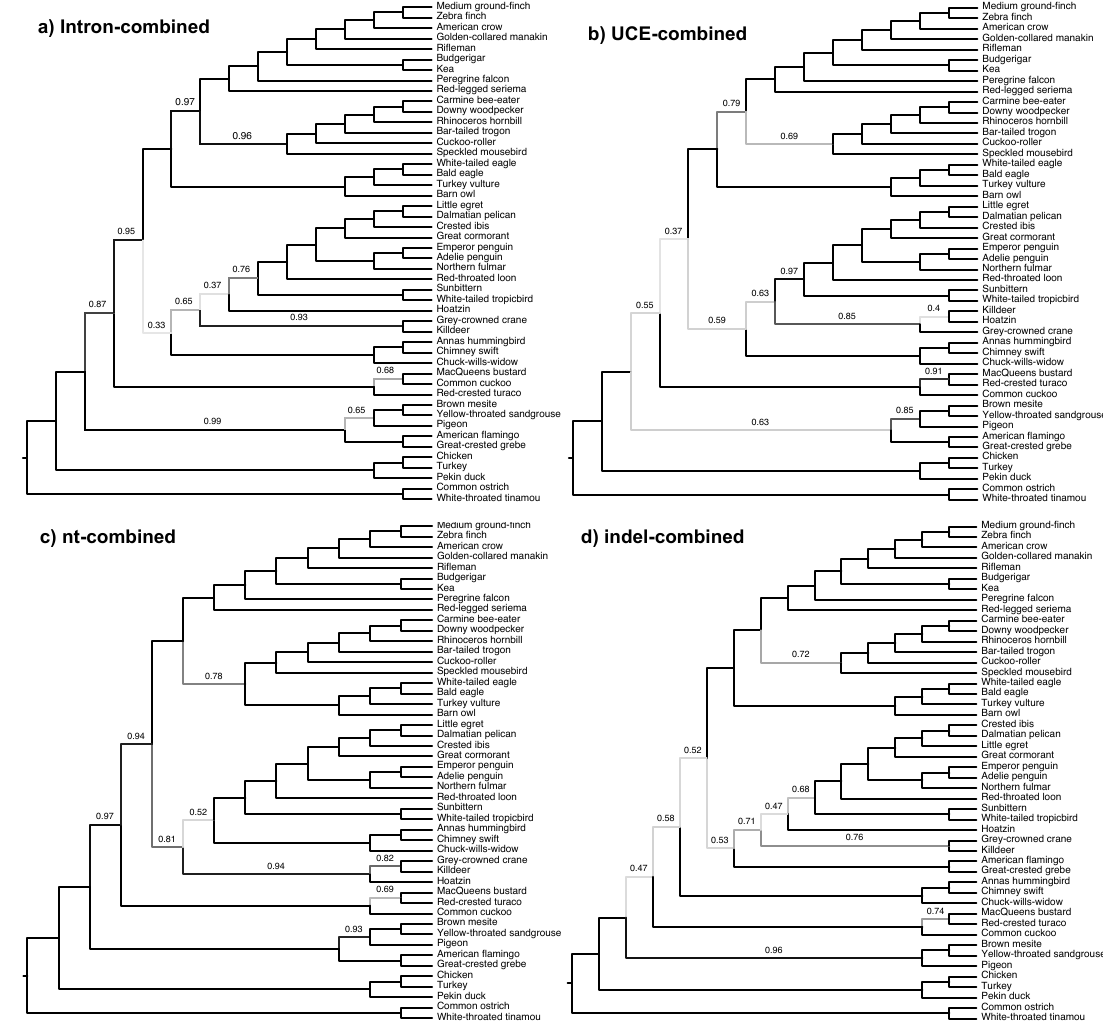
Figure 11. ASTRAL trees using combined dataset gene trees with branches with up to 5% BS contracted. ( a ) Intron-combined = intron nt + indel gene trees; ( b ) UCE-combined = UCE nt + indel gene trees; ( c ) nt-combined = intron + UCE nt gene trees; and ( d ) indel-combined = intron + UCE indel gene trees. Branch labels are localPP < 1.0. Note, in computing branch support of intron-combined and UCE-combined trees, every two gene trees of the same locus are counted as 1 to avoid double